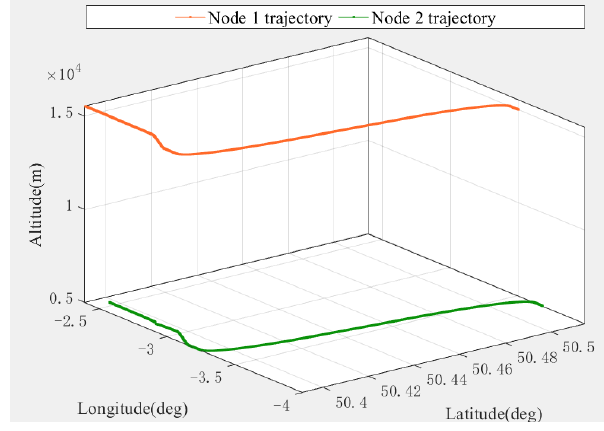
Figure 4. Reference airspace assembly trajectory of formation aircraft. Table 1. Reference aircraft and navigation sensor parameters.